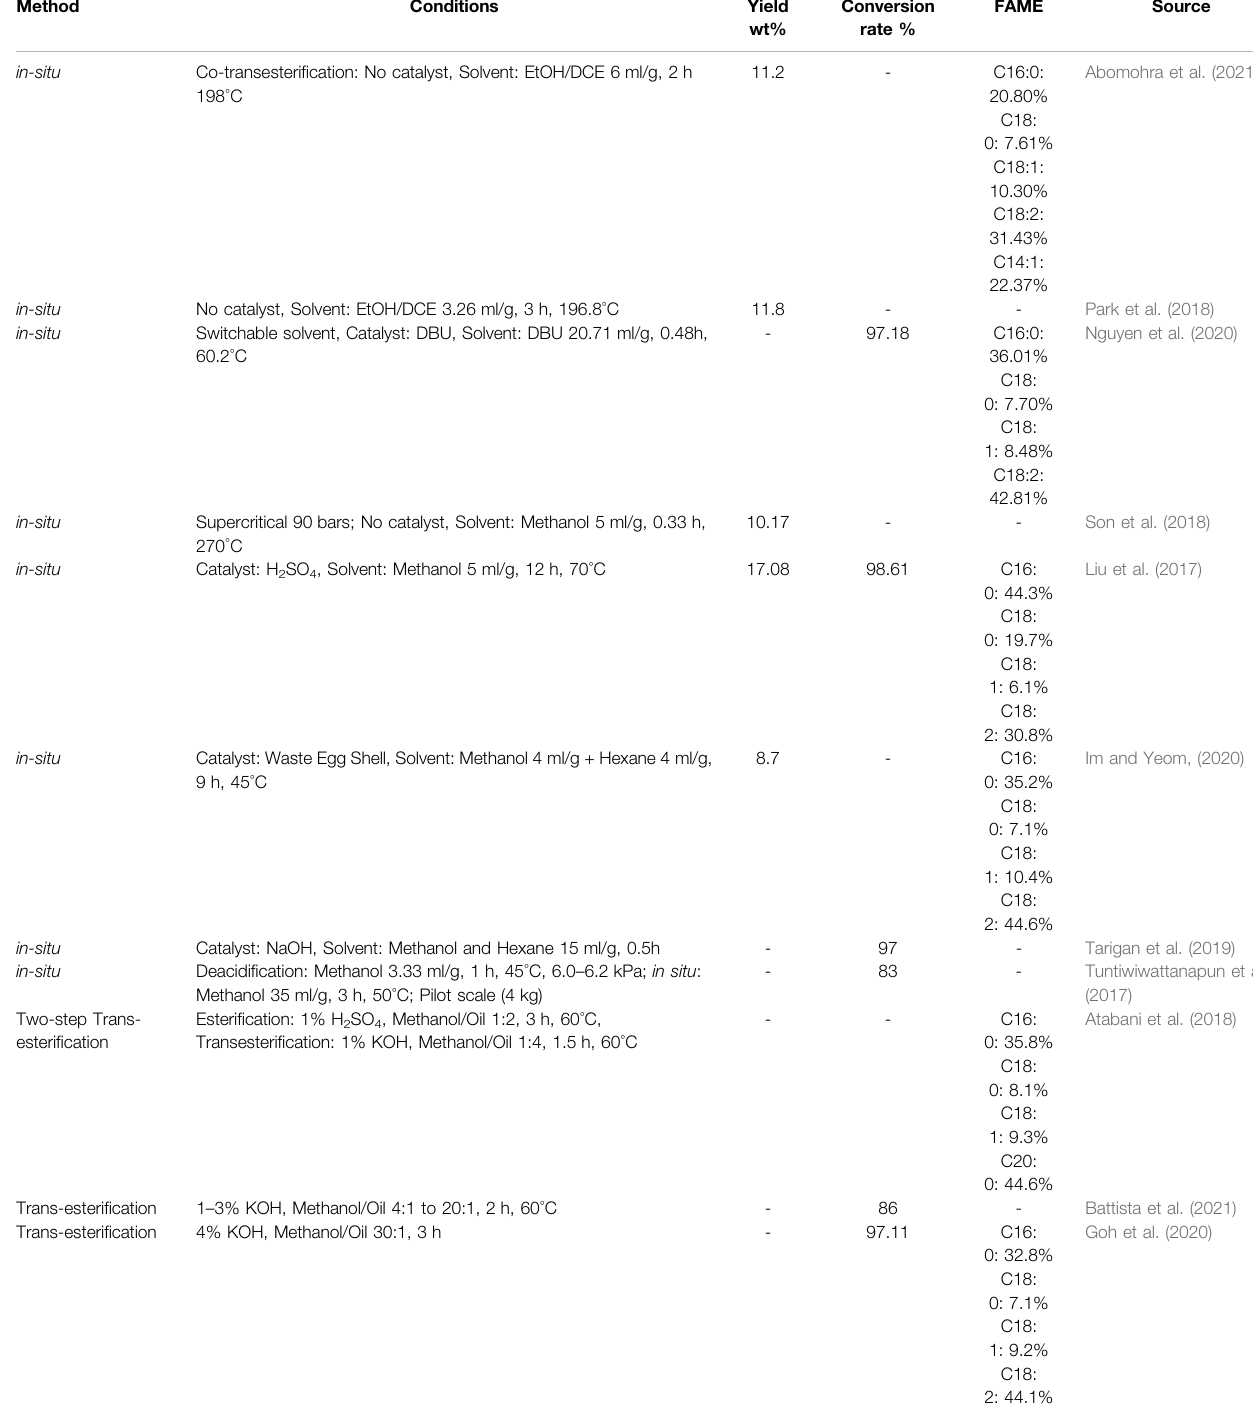
TABLE 4 | Recent studies on converting SCG oil to